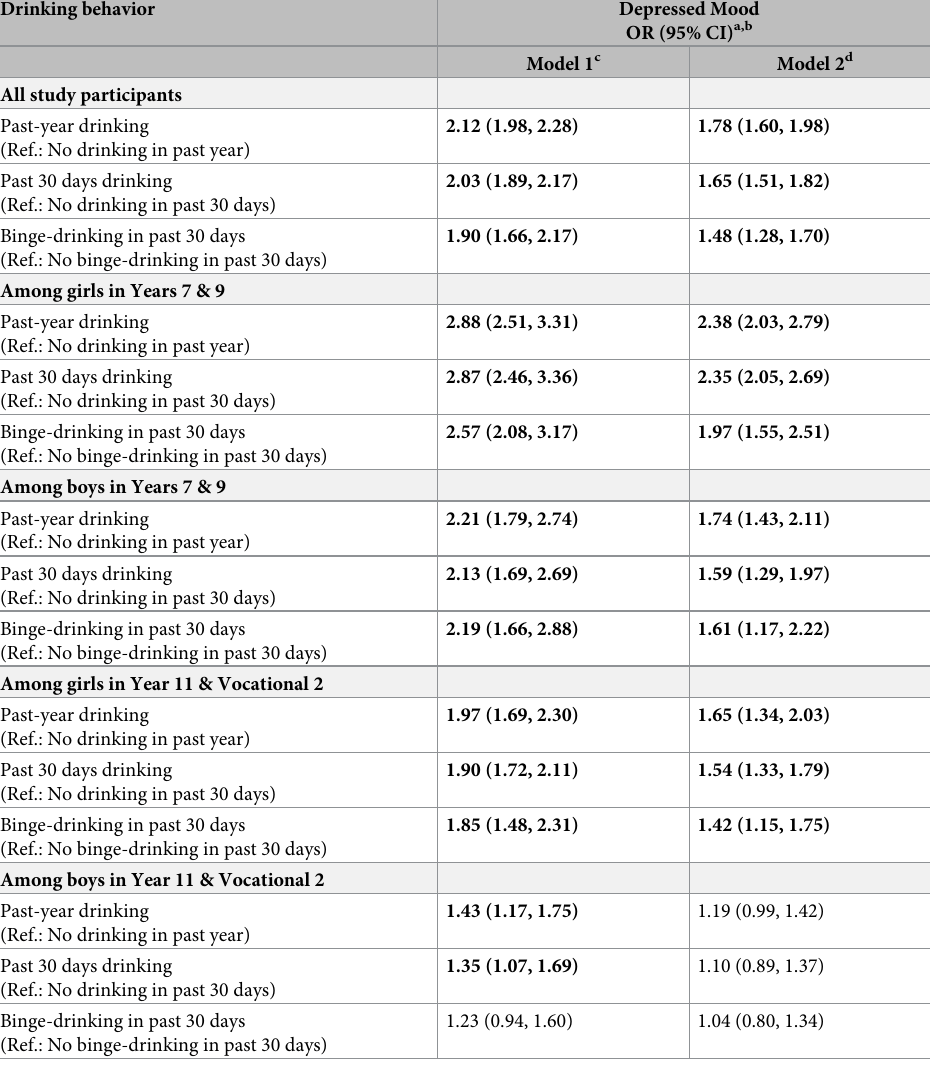
Table 3. Association between alcohol consumption behaviors and depressed